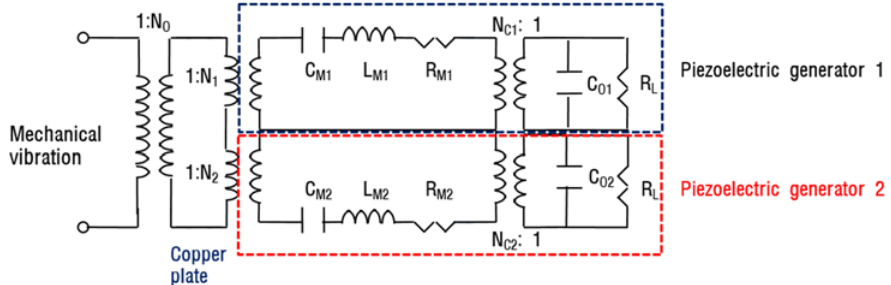
Figure 6. Simplified equivalent circuit model representing a double piezoelectric cantilever genera- tor.